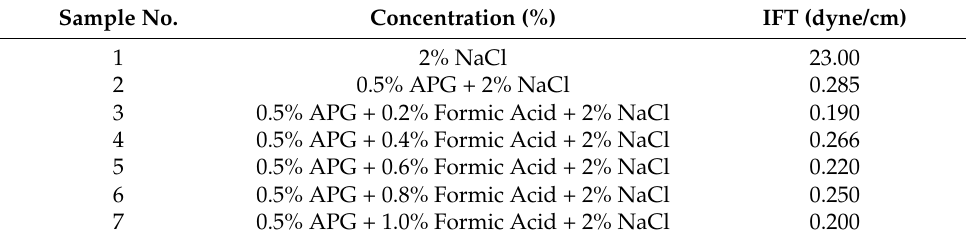
Figure 10. IFT measurements as a function of formic acid concentration.